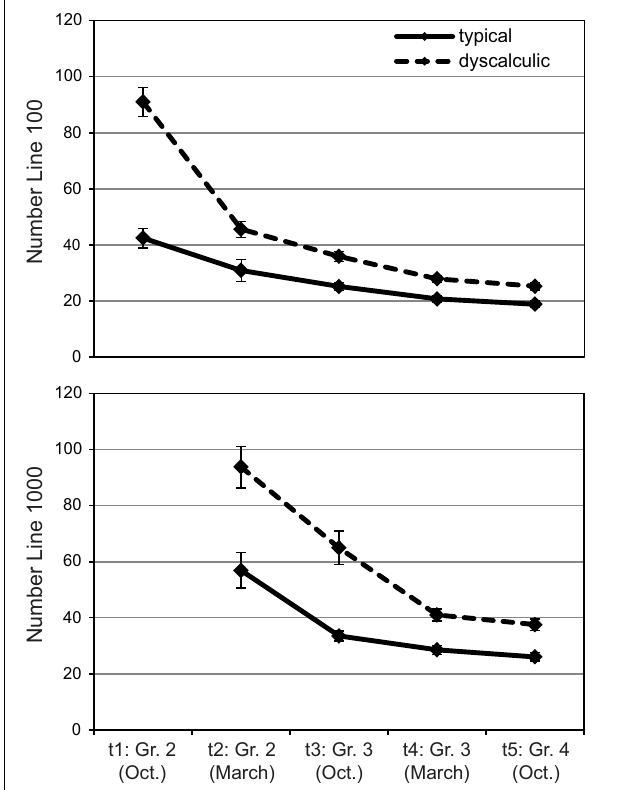
FIGURE 8 | Number line: Mean deviance scores in pixel (SEs as error bars) across five assessment points for number lines 100 (top) and 1000